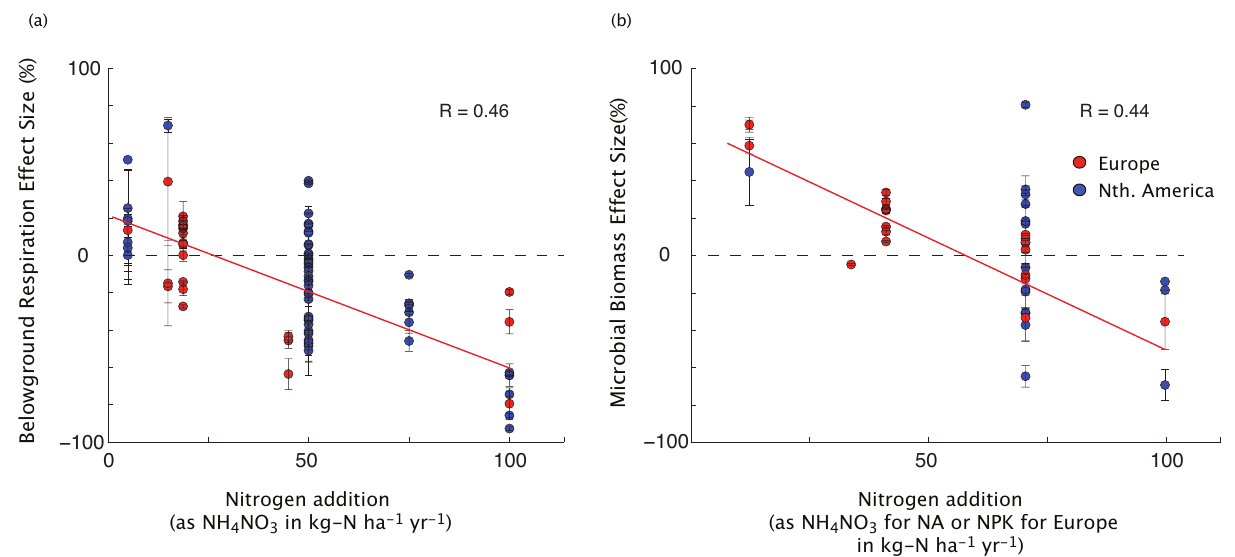
Figure 4. The effect of increasing N addition on (a) belowground respiration and (b) microbial (i.e., bacterial + fungal)